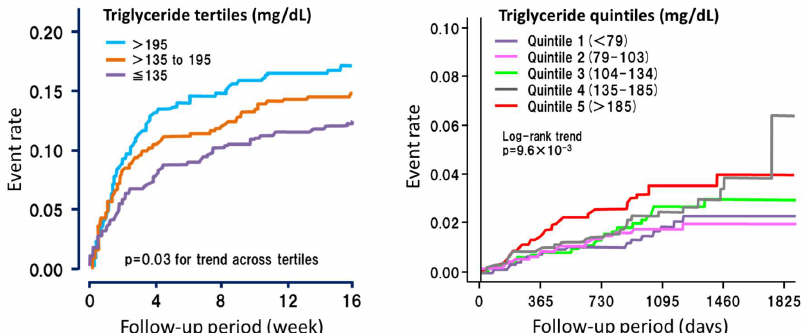
Figure 3. Cardiac events and triglycerides under statin therapies.